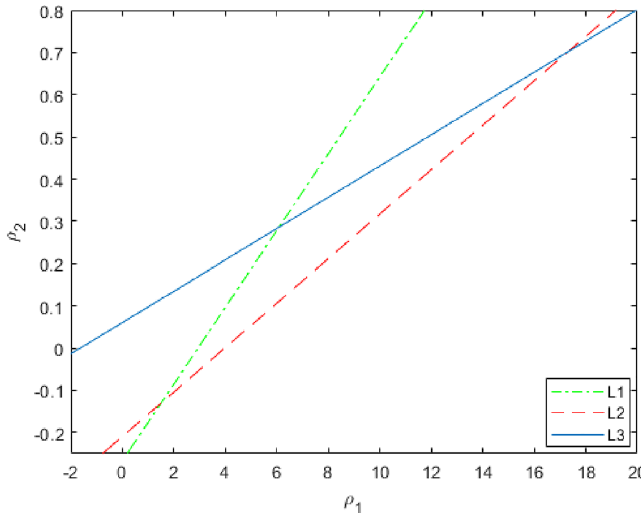
Figure 17. Stability region of the controlled System (28).